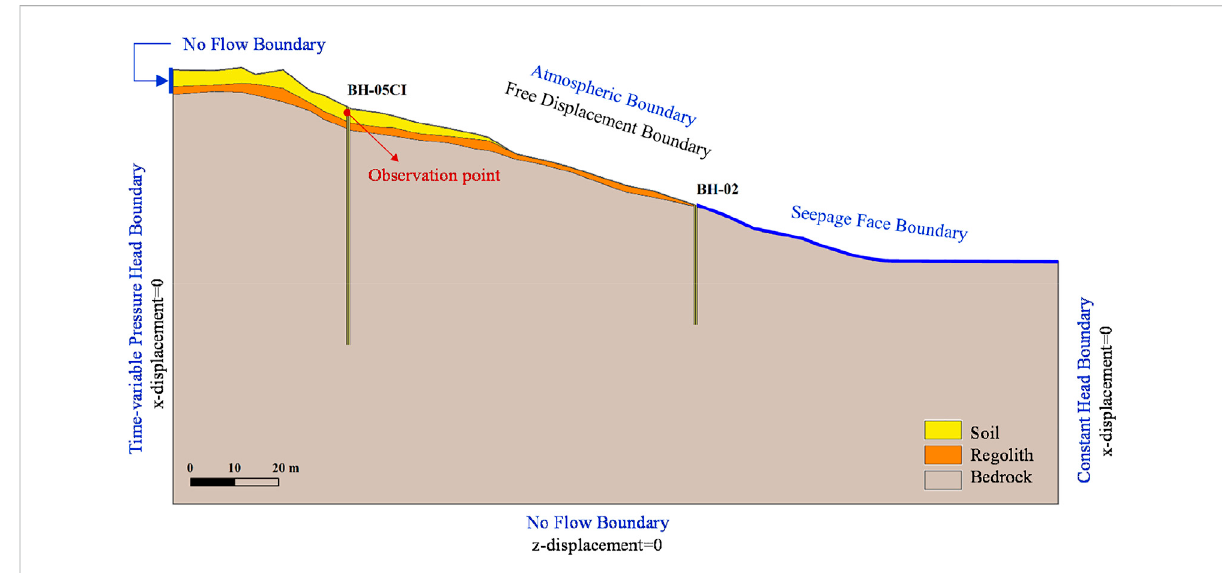
FIGURE 3 Conceptual model of slope geometry and boundary